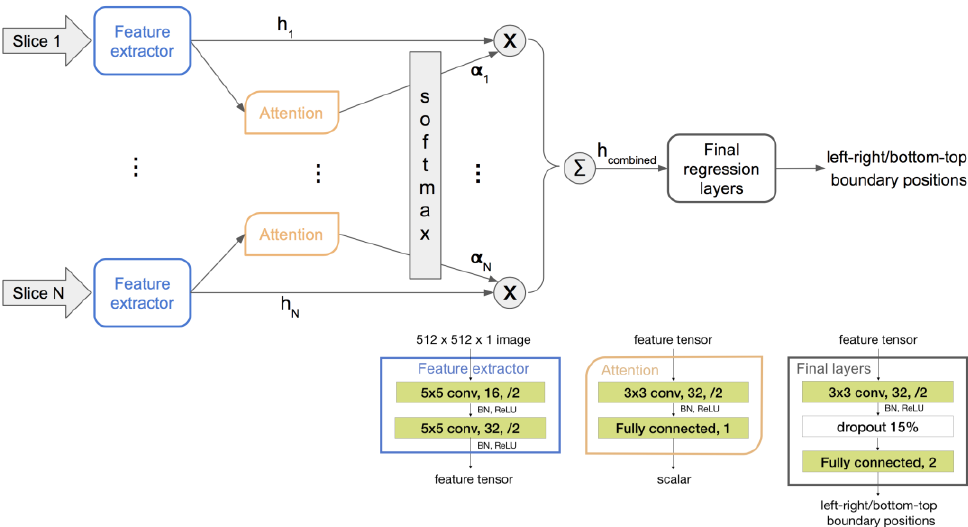
Figure 4. Network flow (top half) and architectures (bottom right corner) of the proposed framework, where x represents element-wise multiplication and Σ represents summation, α represents scalars that sum to one, and h represents image features. The number following “Fully connected” represents the number of output nodes of that layer. There is only one instance of the feature extractor and the attention network, and they are shared across all slices.